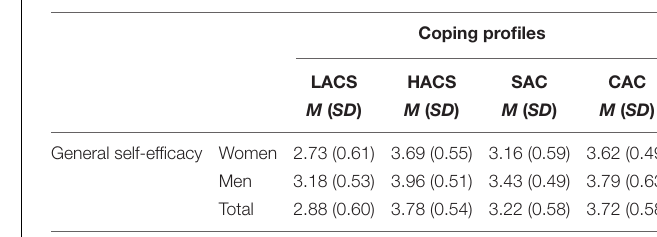
TABLE 5 | Descriptive statistics (means and standard deviations) corresponding to coping profiles in general